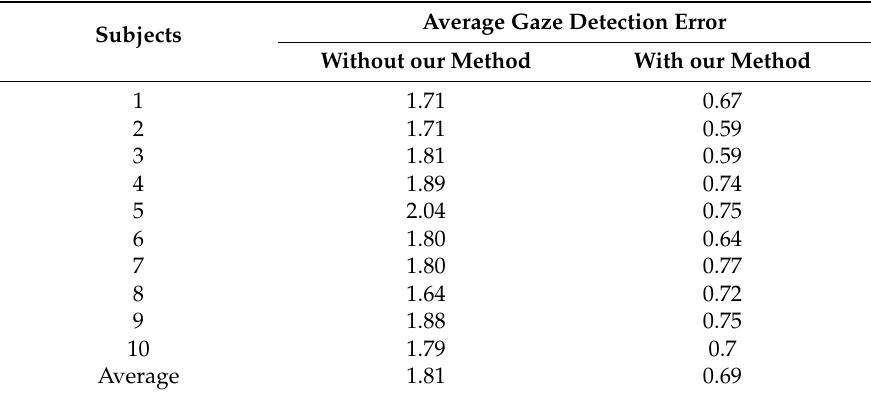
Table 4. Individual gaze detection errors with or without our method (unit: ˝